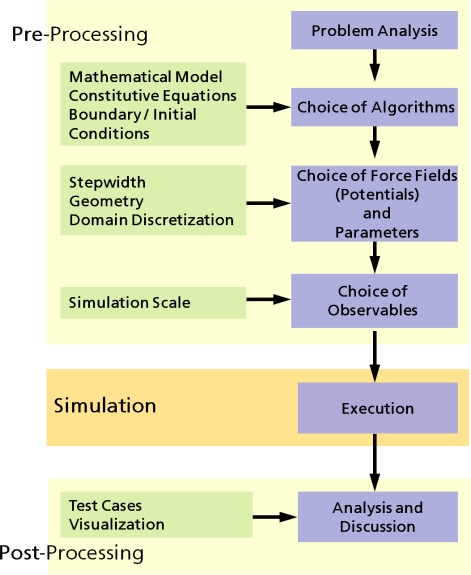
Principal design of a computer simulation. Usually, some pre-processing as preparation for the main simulation is done with a pre-processor. This piece of computer code might be integrated in the main source code or – in particular in commercial codes –is written as an extra piece of code, compiled and run separately from the main simulation code. During pre-processing, many administration tasks can be done which are not related to the actual simulation run. In large-scale simulations, data are stored during execution for later analysis. This analysis and visualization is done during post-processing. The advantage of separating pre- and post-processing from the actual simulation code is that the code design remains clearly arranged and the important issue of optimization for speed only has to be done for the relevant pieces of the main simulation code. However, in large-scale simulations, involving billions of particles, even the task of data analysis can become a major problem that needs optimization and fast parallelized algorithms [41].